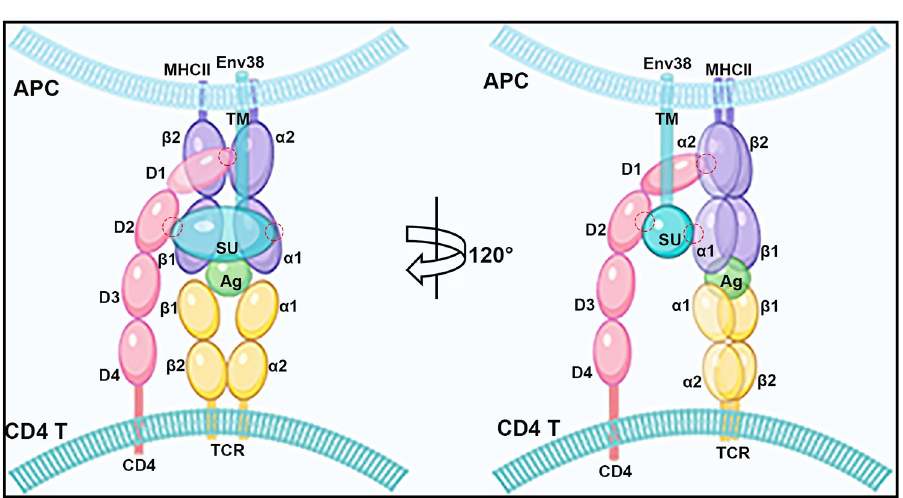
CD4 + T cell activation. Env38 located on the surface of MHCII + APC in an integral form without undergoing cleavage between the transmembrane subunit (TM) and the surface subunit (SU). Env38 was associated with MHC-II α and CD4 proteins, in which the SU subunit of Env38, the second immunoglobin domain of CD4 (CD4-D2) and the first α 1 domain of MHC-II α chain (MHC-II α 1) contribute to the association among Env38, CD4 and MHC-II α proteins. In particular, Env38 specifically binds to CD4-D2 and MHC-II α 1 domains without intervention with the CD4-D1 and MHC-II β - β 2 as well as CD4-D1 and MHC-II α 2 domains, two previously known reciprocal connectors contributing to